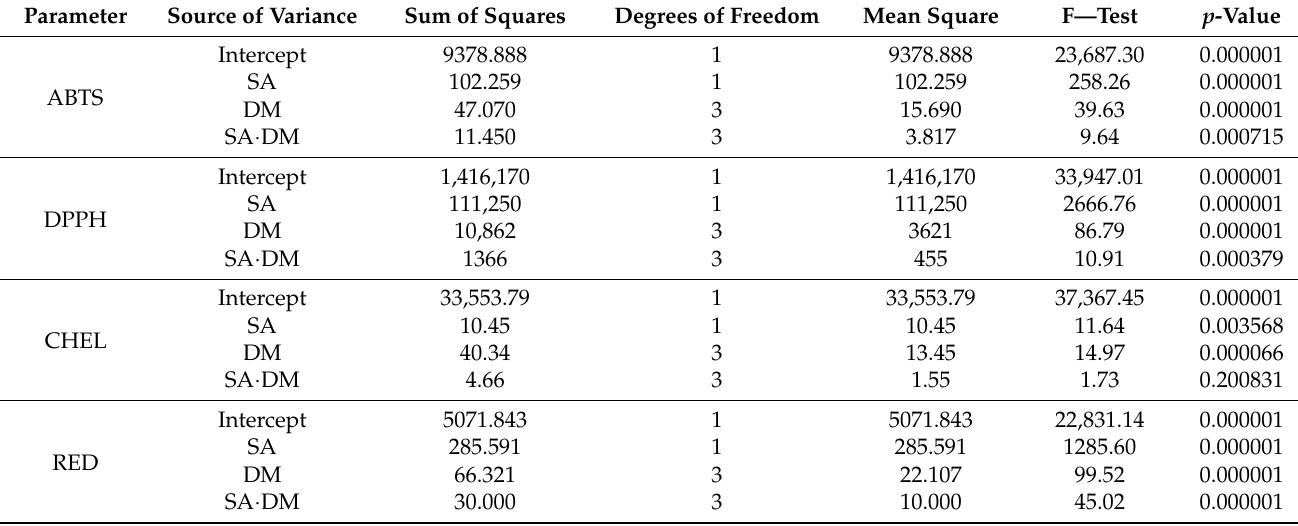
Table 10. The analysis of variance for parameters characterizing antioxidant properties of dried leek.